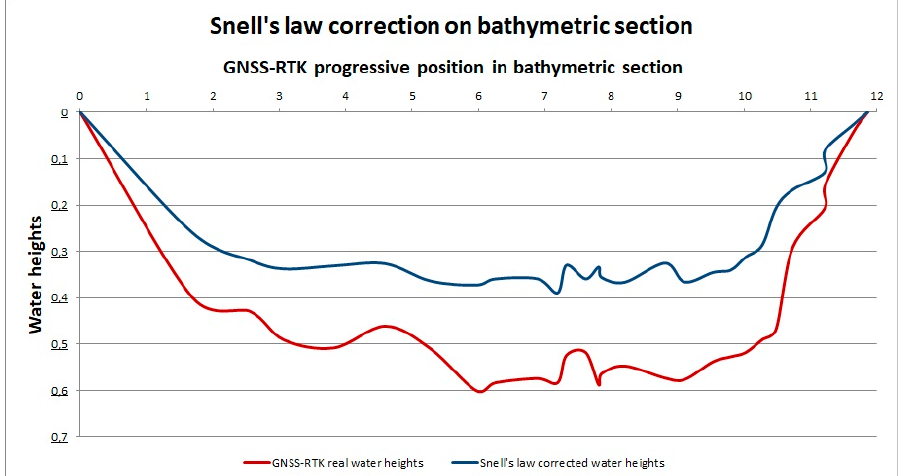
Figure 8. Example of Snell’s law WDC factor application on an Orco river bathymetric section.